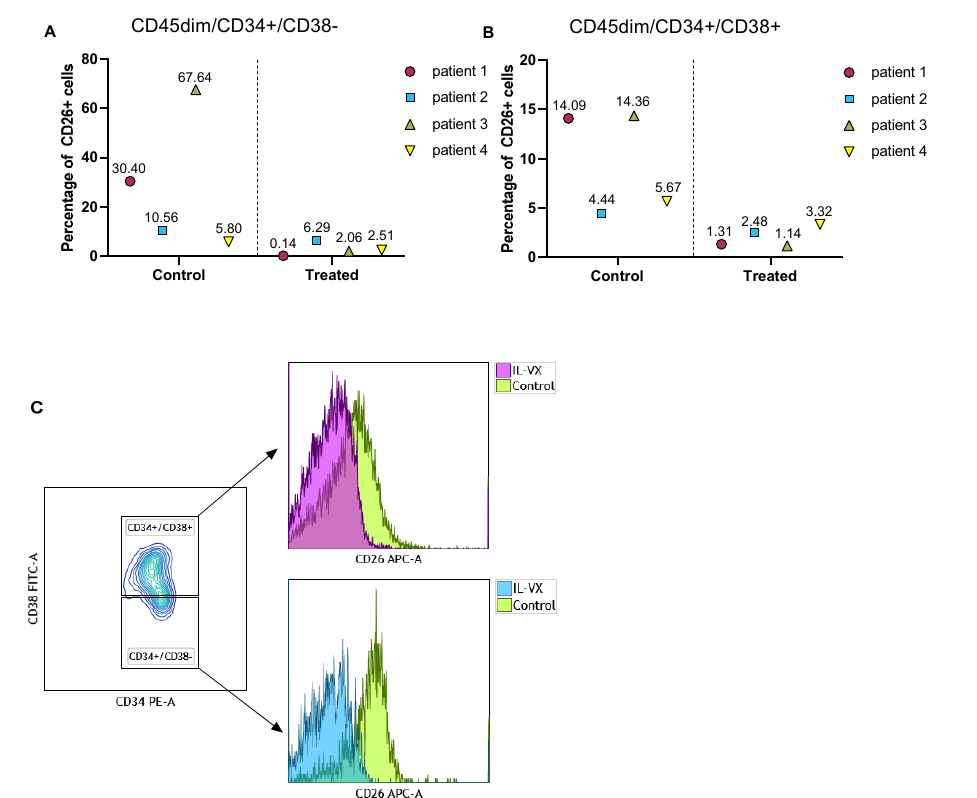
Figure 7. Treatment of primary CML samples with IL-VX. Following treatment of MNCs from four newly diagnosed CML samples with 100 nM IL-VX, a significant reduction of CD26+ cells in CD45dim/CD34+/CD38 − stem cells population and in CD45dim/CD34+/CD38+ progenitor cells was recorded ( A , B ). Flow cytometry graph of one newly diagnosed patient sample treated with 100 nM IL-VX is displayed in ( C ), where reduction of CD26+ cells in both stem cells and progenitor cells fraction is evident.